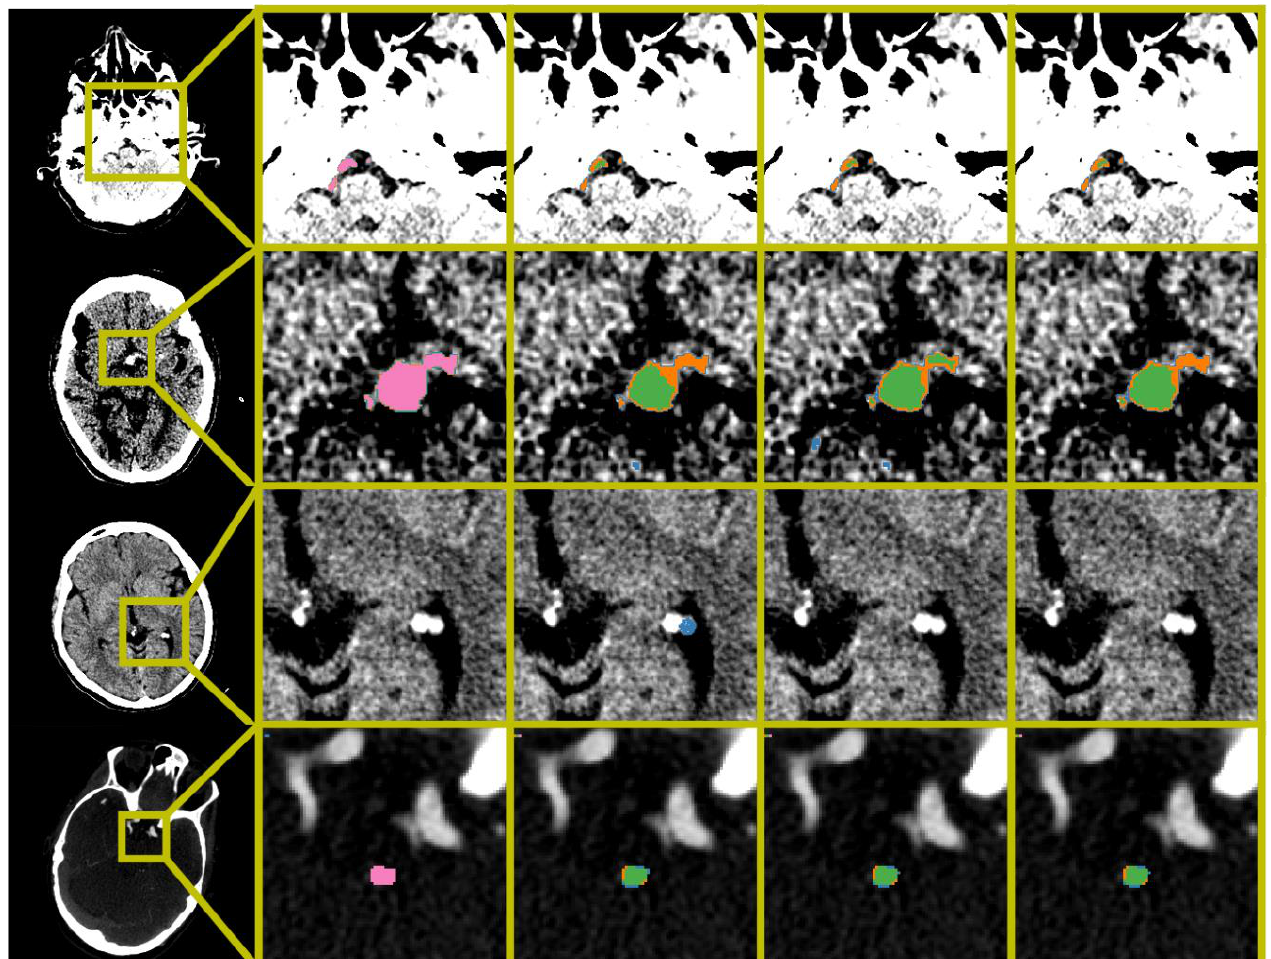
Figure 2. Examples of automatic segmentation results obtained by BL-UNet and Polar-UNet. From the left to right column: The original scan with a bounding box indicating the zoom location, the ground truth segmentation map, the results obtained from the BL-UNet without volume-based removal (VBR), the results obtained from the Polar-UNet without VBR, and the results obtained from the Polar-UNet with VBR. The top three rows display NCCT scans; the bottom row shows a CTA scan. The top row shows the difficulty all CNN methods have with segmenting a thrombus in the vertebral arteries. The second row from the top shows an example of small false positives removed by the VBR step. The third row from the top row shows false positives that are removed by restricting the volume-of-interest to the posterior circulation with Polar-UNet. The bottom row shows an example of a scan without a hyperdense artery sign. The segmentation maps show the ground truth (pink), true positive (green), false negative (orange) and false positive (blue). The NCCT scans were plotted using a window center level of 35, with a window width of 30. The CTA scan was plotted using a window center level of 300, with a window width of 600.